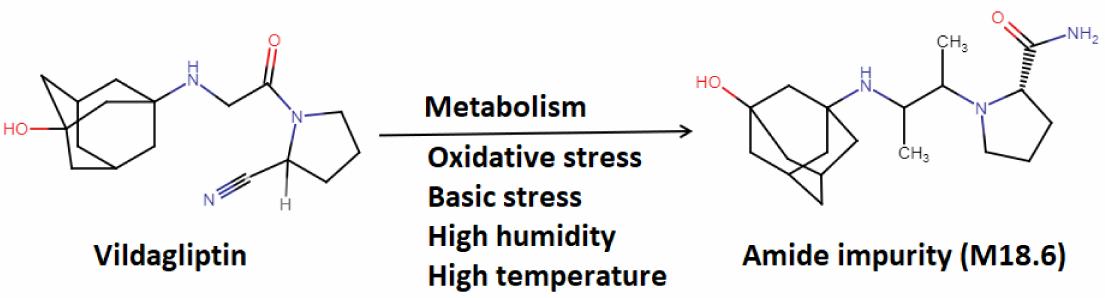
Figure 1. Metabolism/degradation of vildagliptin to amide impurity/M18.6